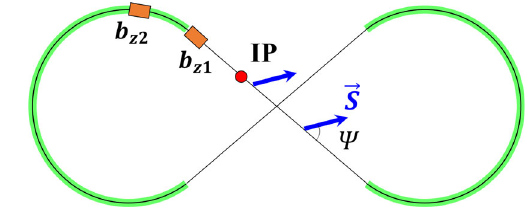
Fig. 1 SN based on two solenoids